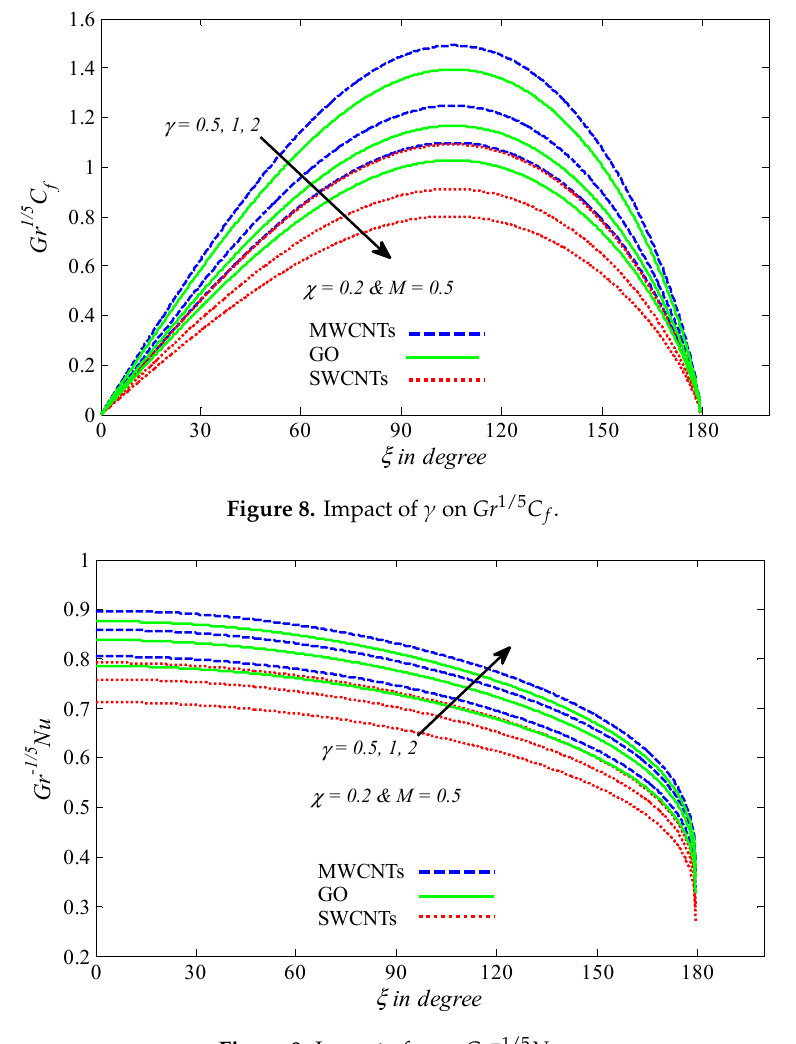
Figure 10. Impact of M on θ .